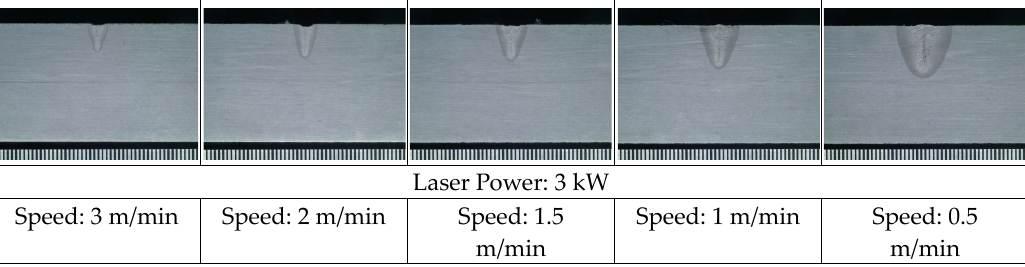
Figure 5. Bead geometry on BOP welding test (laser power: 3 kW).